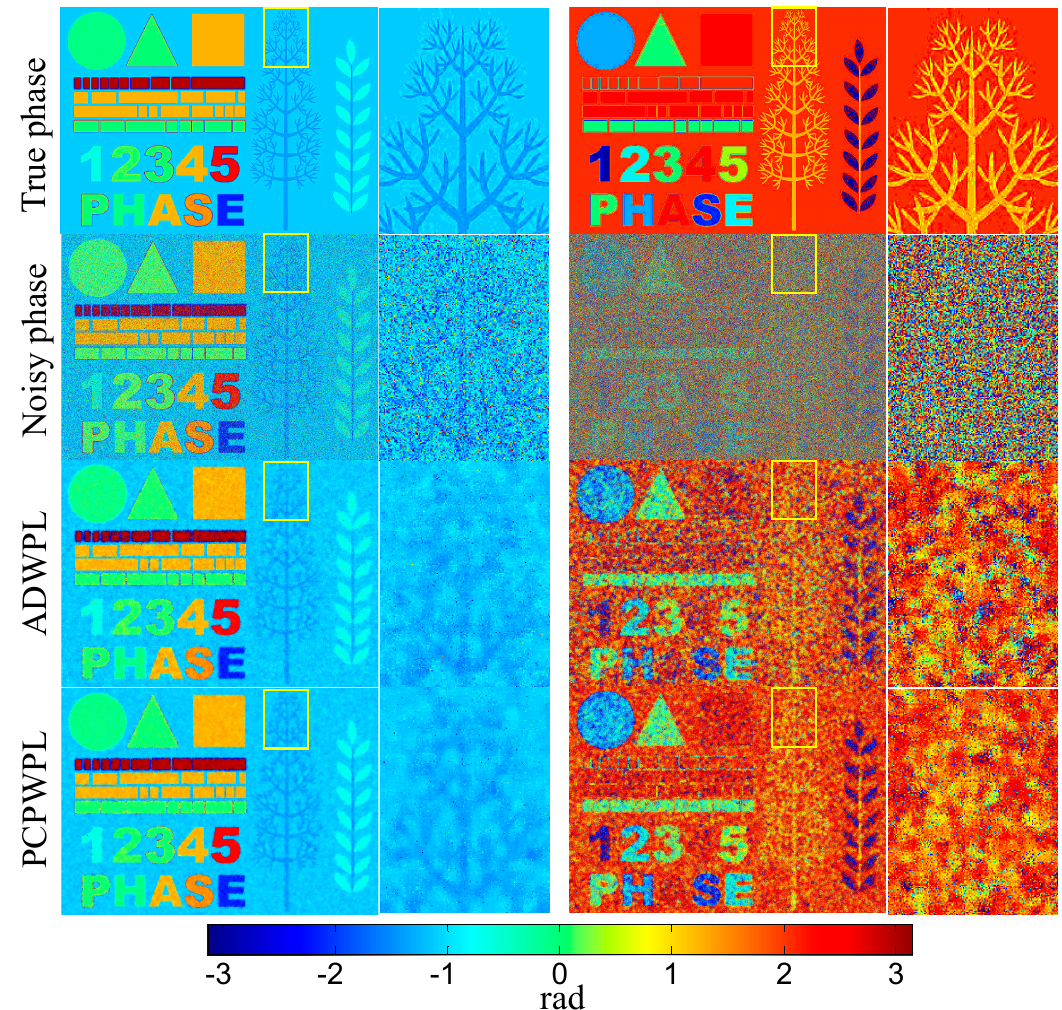
Figure 7. Homogeneous filtered interferograms for the N = 40 simulated data stack, with the boxed patch enlarged for better interpretability. ( left ) A relatively high coherence pair and ( right ) a relatively low coherence pair.